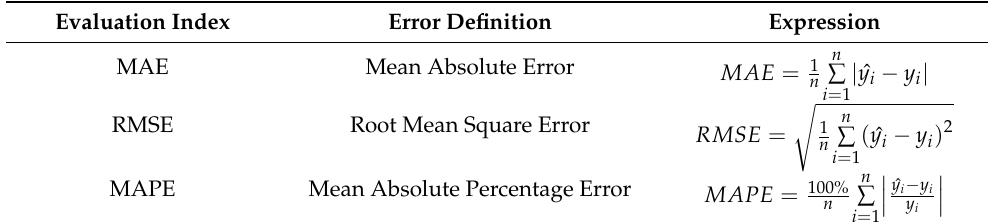
Figure 8. Correlation between cooling load and heat load. Table 2. Evaluation